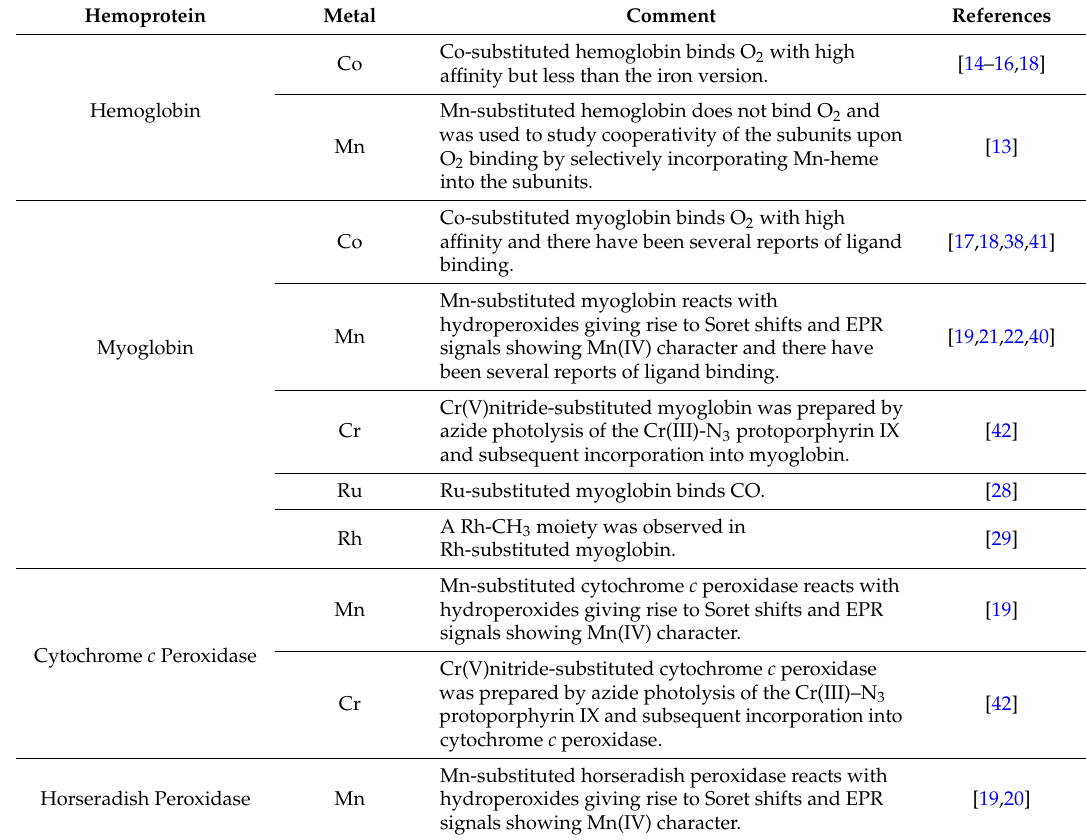
Table 1. Transition metal substituted hemoproteins and their chemical and spectroscopic properties. EPR refers to electron paramagnetic